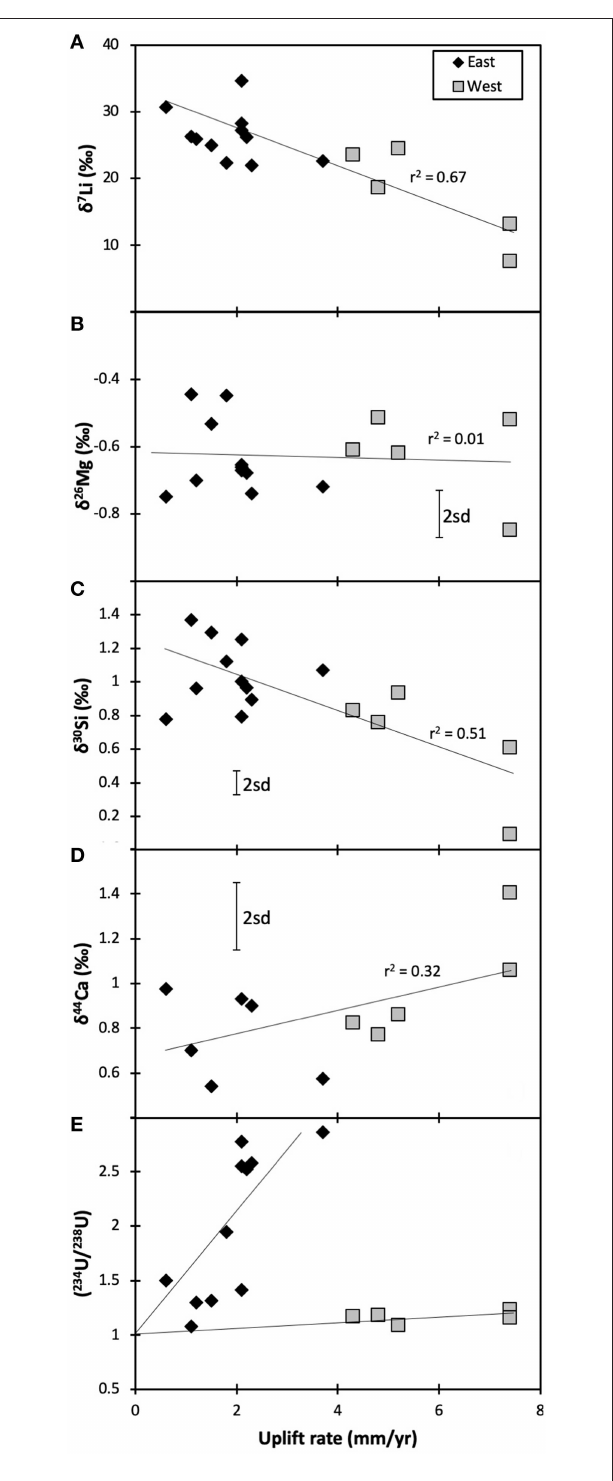
FIGURE 3 | Isotope ratios of Mg (B) , Si (C) , and Ca (D) plotted against uplift rates, which are used as a proxy for fresh rock exposure rates. The trends of Li [ (A) ; Pogge von Strandmann and Henderson, 2015] and U isotopes [ (E) ; Robinson et al., 2004] relative to uplift rates are also shown. Overall, the figure suggests that isotopes of trace elements may provide more weathering information than those of major elements. The error bars represent the long-term 2sd external